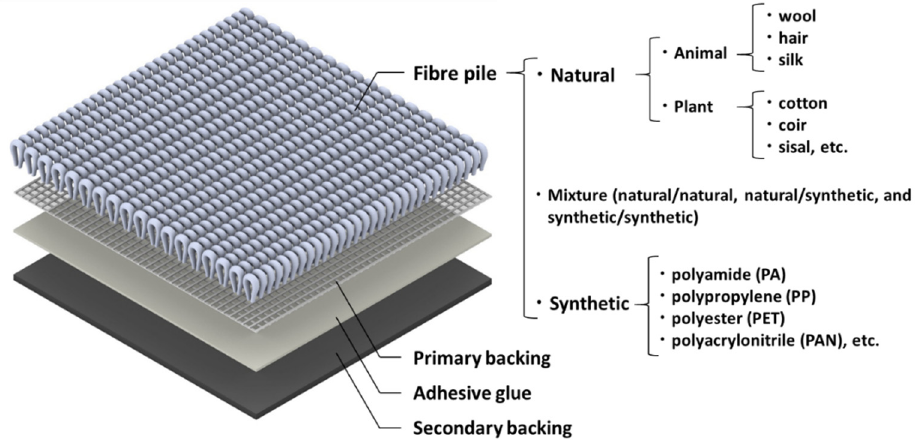
Figure 2. The structure of carpets and categorization of the natural and synthetic fibre carpets.